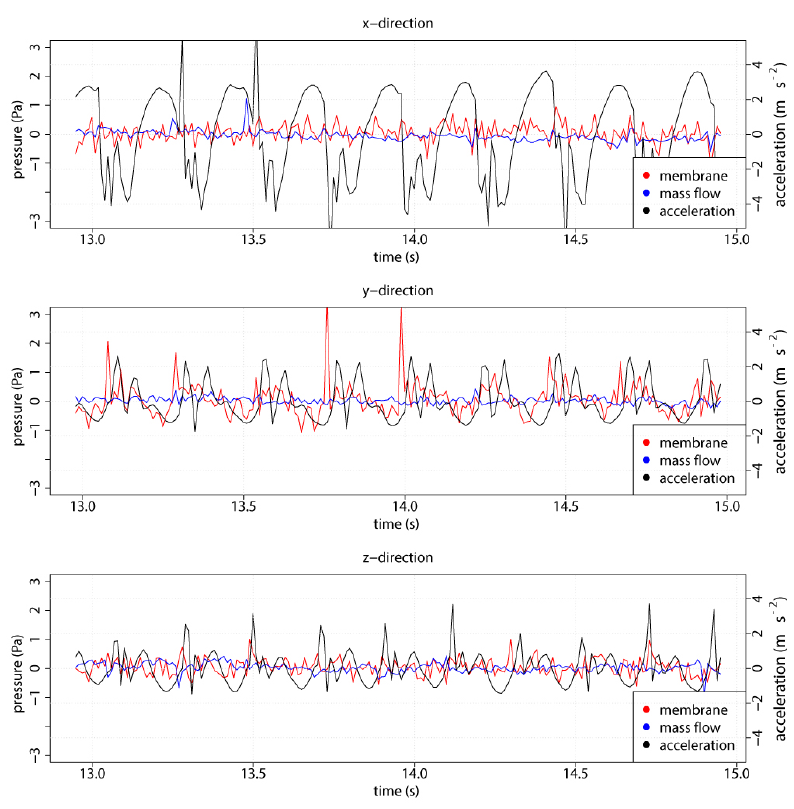
Fig. 15. Vibration/acceleration applied to pressure transducers in distinct directions